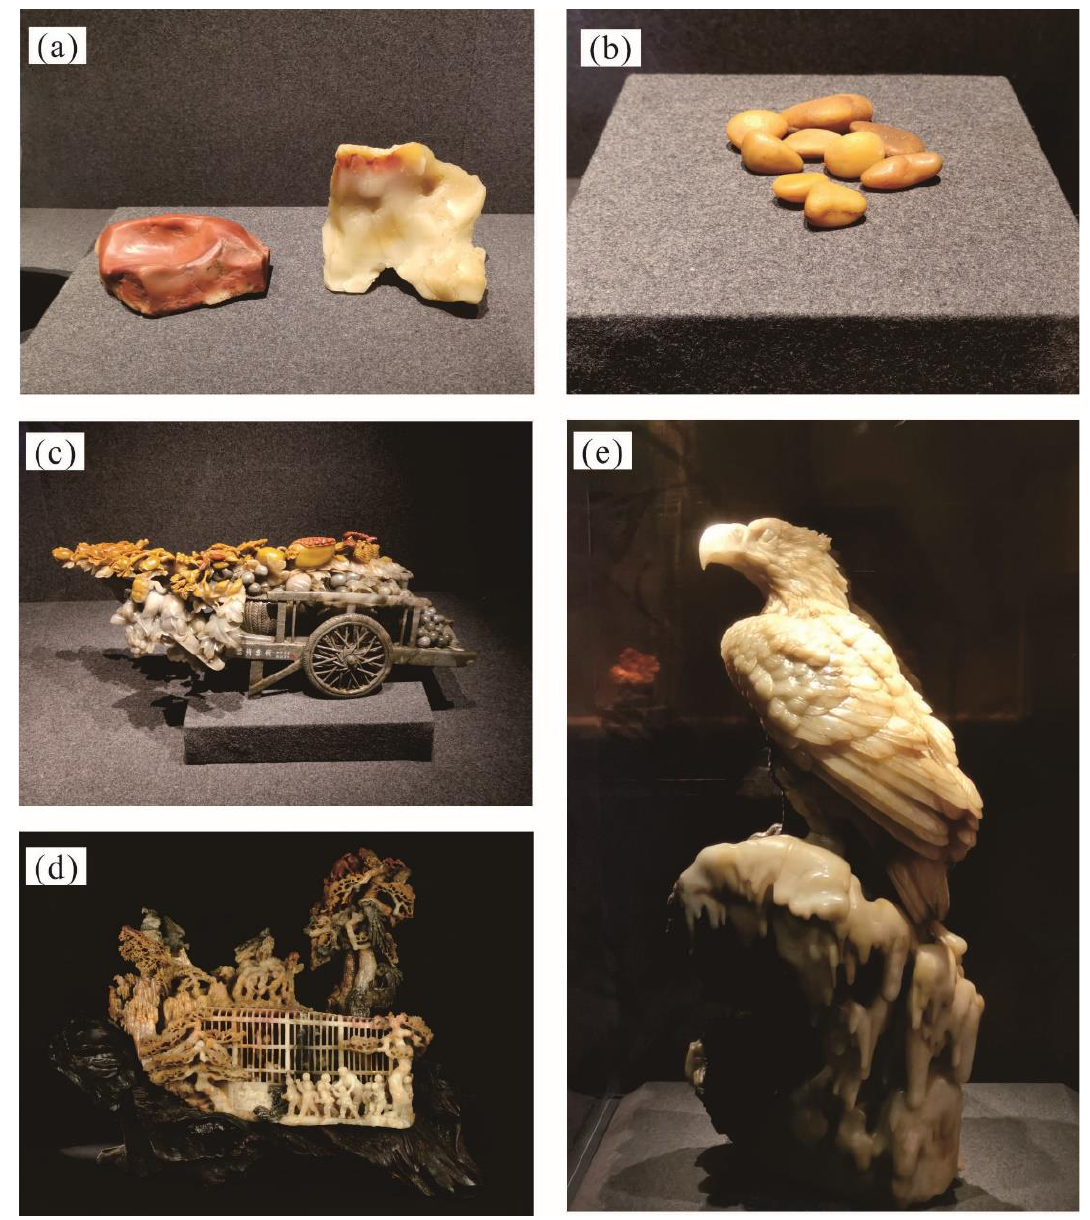
Figure 1. ( a , b ) Typical raw gemstone; ( b – e ) arts and crafts in China Shoushan Stone Museum.